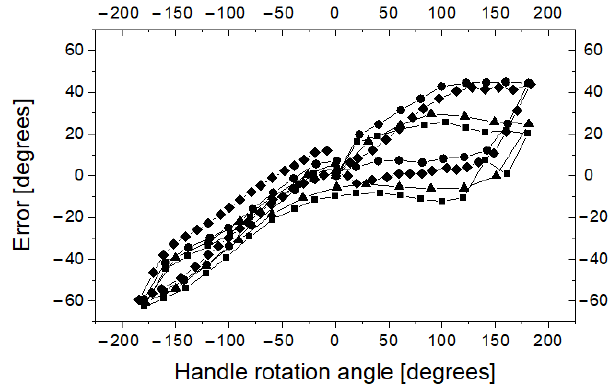
Figure 14. Hysteresis in the measuring system of the D2 device in relation to R2.